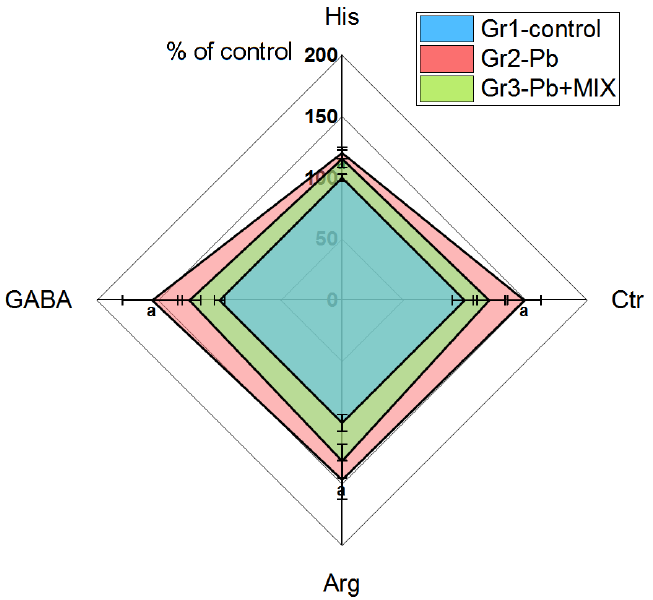
Figure 2. The changes of the biomarkers evaluated in liver ( n = 6; a indicates statistically significant differences between control and Group 2. The results correspond to the mean values (±SE), p < 0.05.